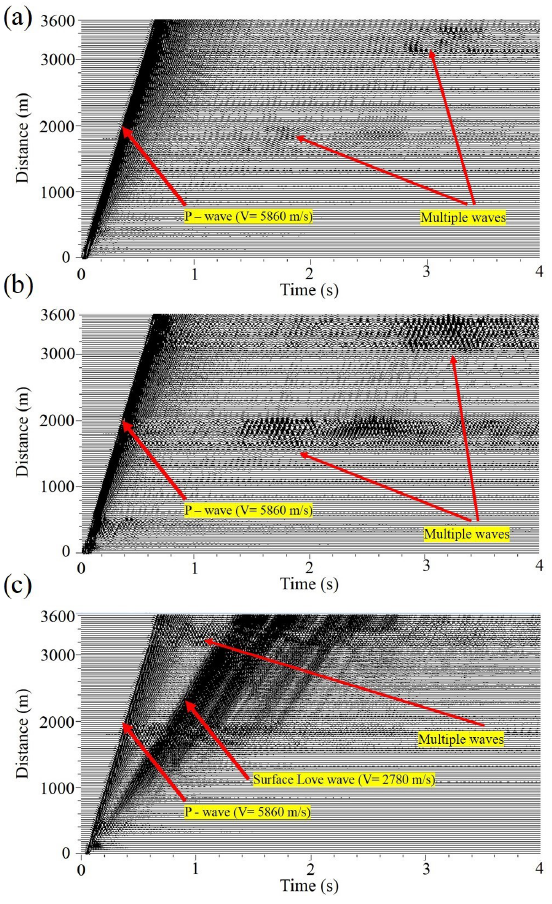
Figure 6. Synthetic seismograms of the blast. The source was lo- cated at an offset of − 300m: (a) vertical channel Z; (b) horizontal channel X; (c) horizontal channel Y.